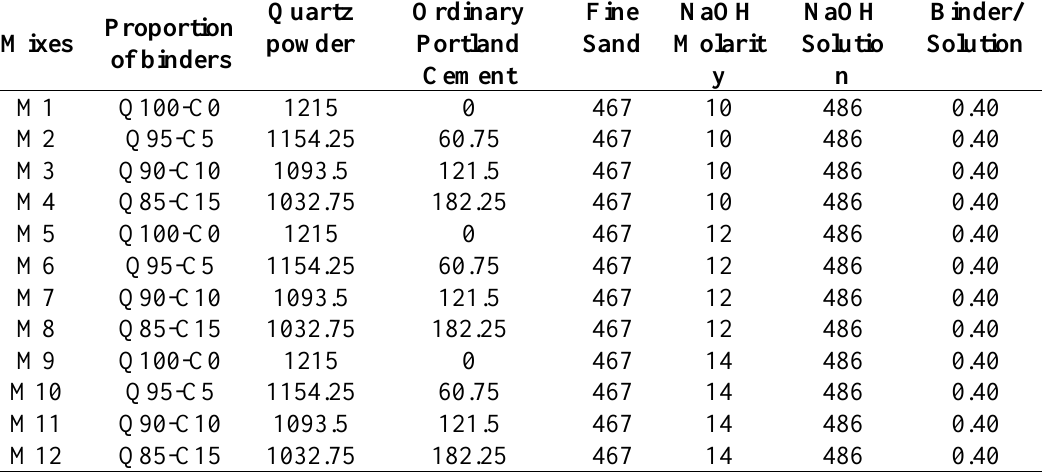
Table 3. Mix proportion of the geopolymer mortar (Kg/m 3 ).